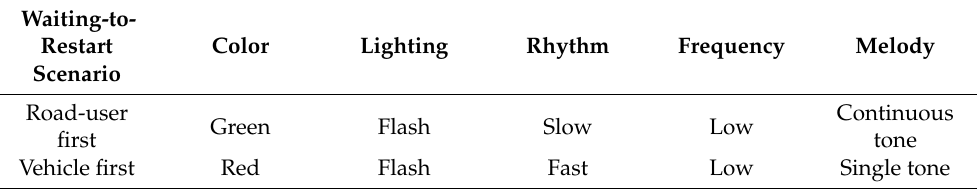
Table 16. Signal combination with the highest average of subjective cognitive assessment based on waiting-to-restart